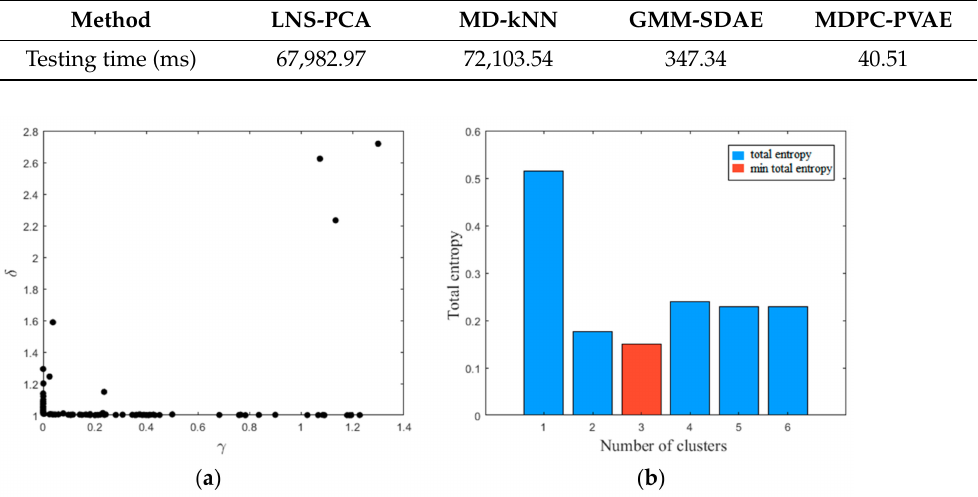
Figure 12. MDPC on the multimode normal data of semiconductor etching process: ( a ) γ − δ decision graph; ( b ) total entropy with different number of